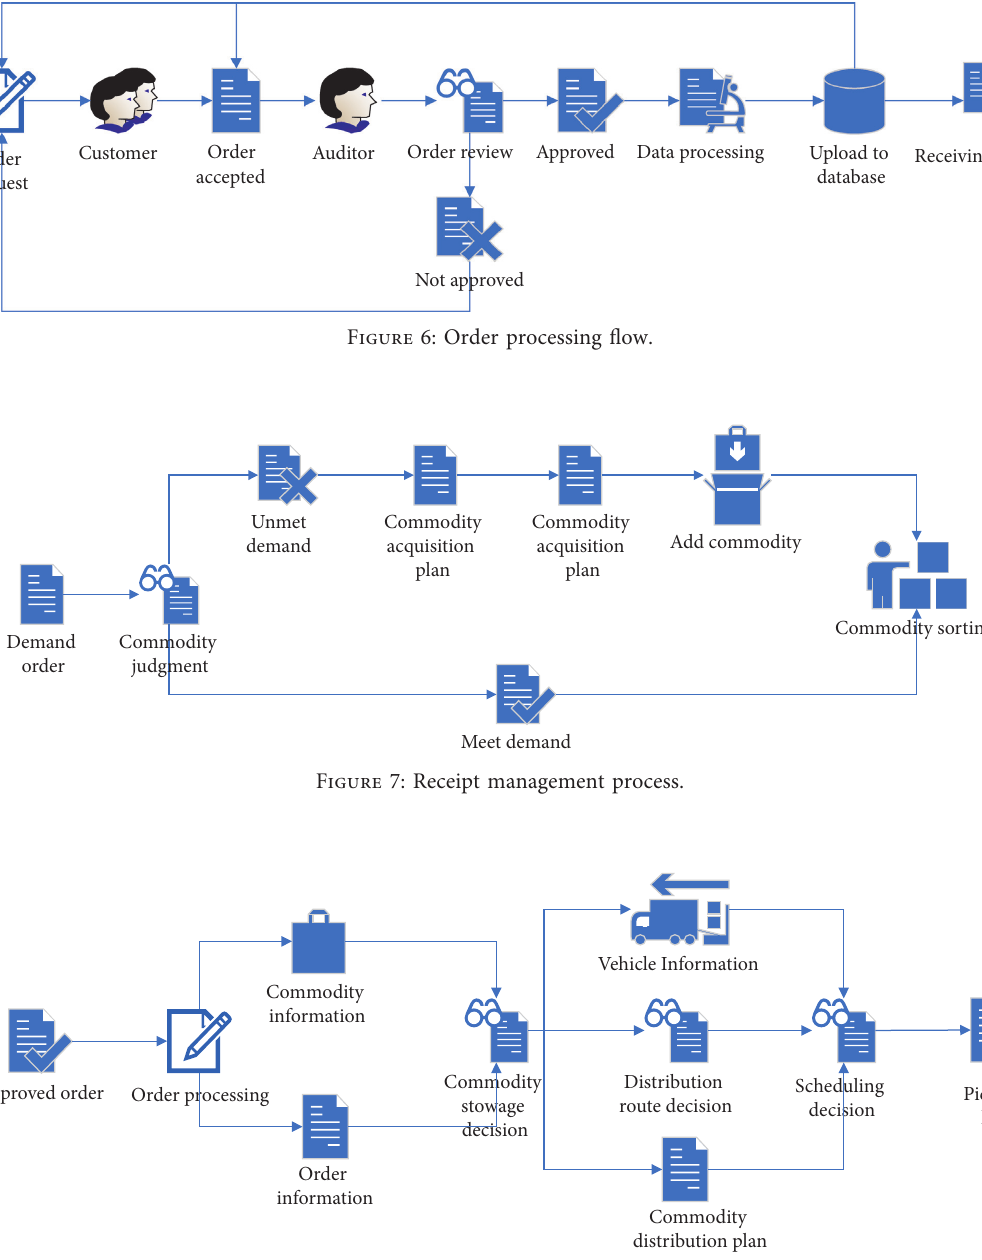
Figure 8: Distribution management